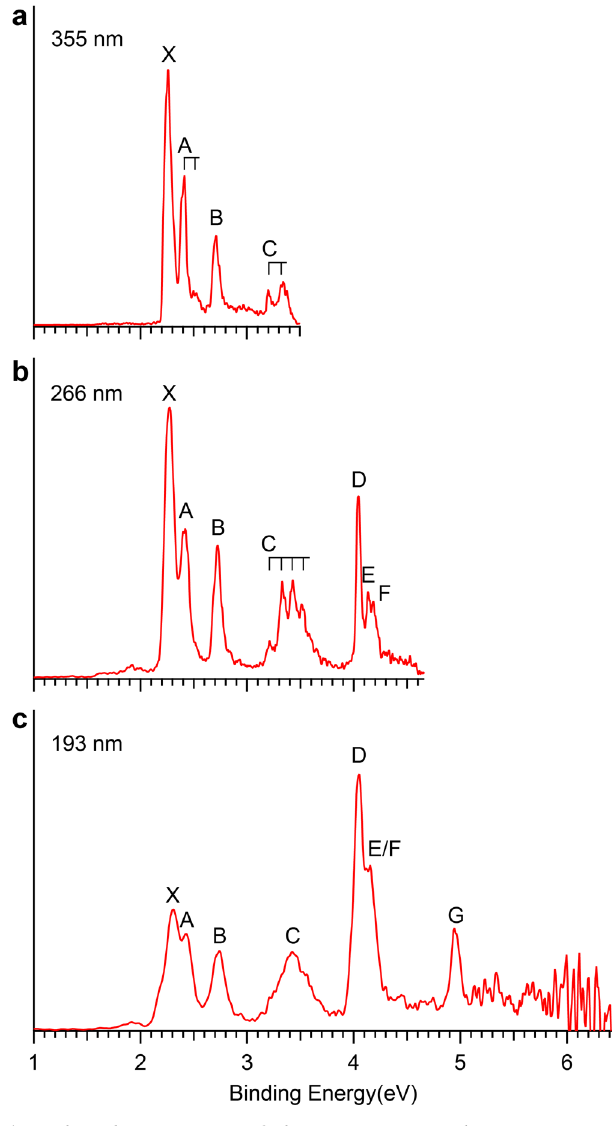
Fig. 1 Photoelectron spectra of PbB 2 O – . a At 355 nm. b At 266 nm. c At 193 nm. The vertical lines represent resolved vibrational